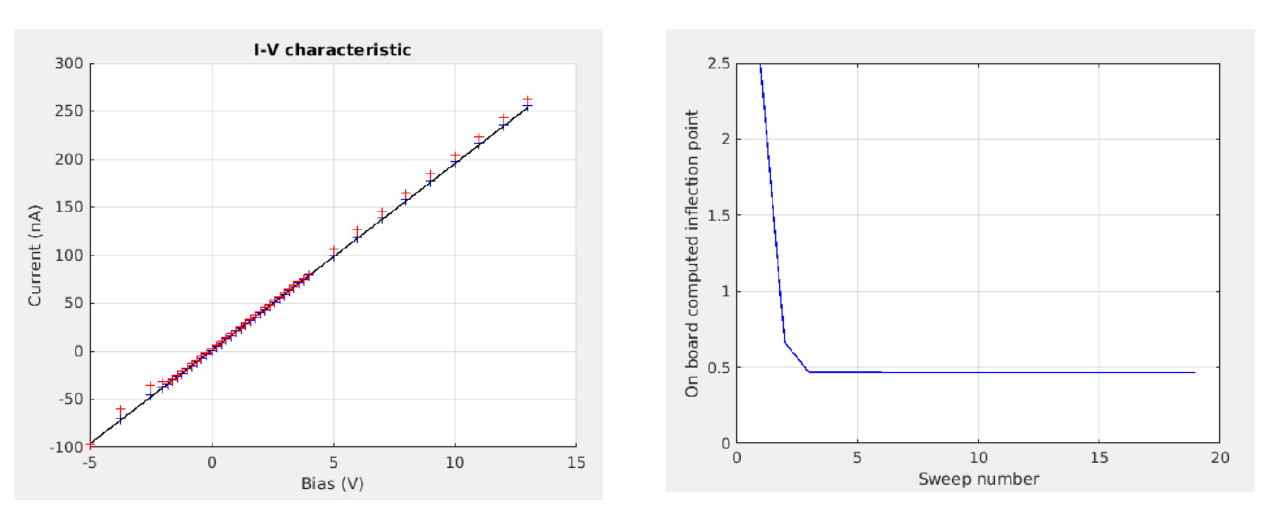
Figure 12. Inflection point computed on board SLP after each sweep for a series of 19 consecutive nominal